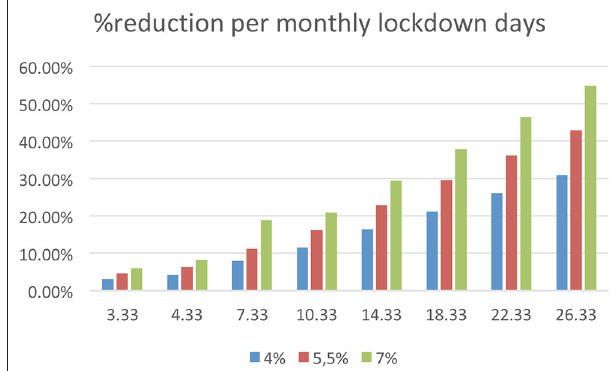
FIGURE 1 | Closing days proposal in order to achieve a given reduction in CO2 emissions, assuming a minimum reduction of 4% per year (blue), average of 5.5% (red), and maximum of 7% (green), based on estimates by Le Quéré et al.